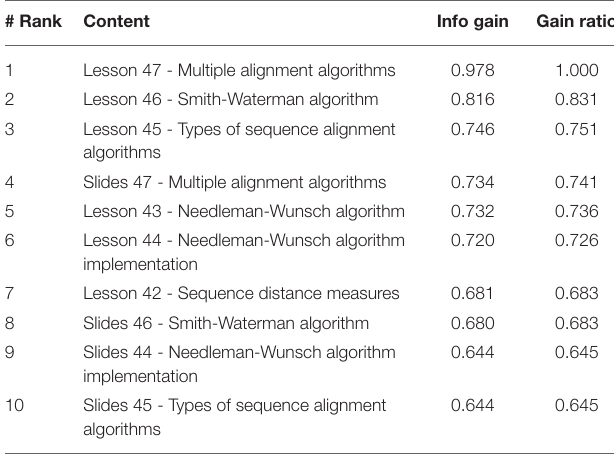
TABLE 2 | Comparison of metrics of a varied set of classifiers. Model AUC Rec.